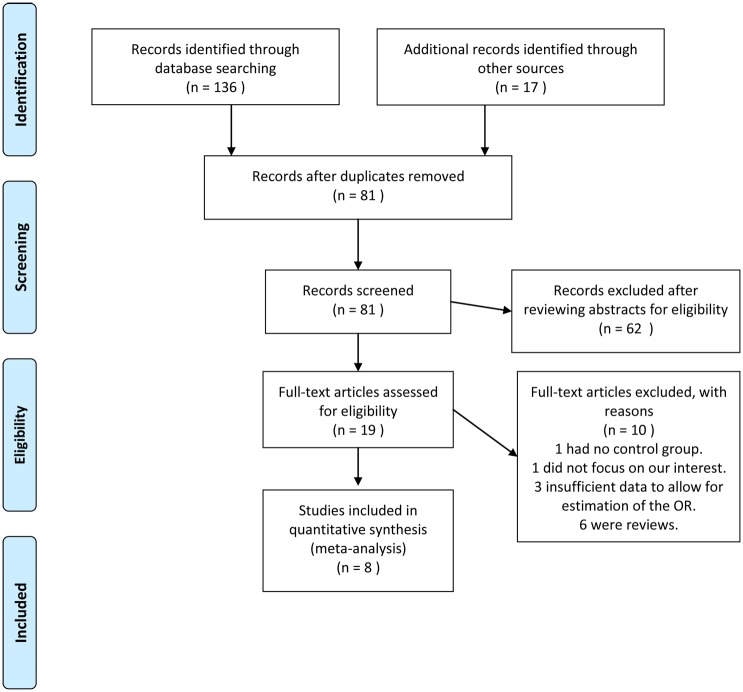
Flow diagram of studies selection process.